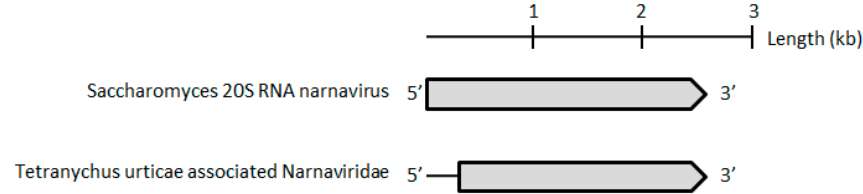
Figure 6. Maximum Narnaviridae likelihood phylogenetic tree based on part of the polymerase protein, including 129 species and Tetranychus urticae-associated narnavirus (in bold). The alignment of 121 amino acids in length was produced using MUSCLE 3.7 (16 iterations) and was ungapped by hand. Bootstrap values are indicated at each node. Scale bar corresponds to amino acid substitutions per site. Genomic organization of Tetranychus urticae-associated narnavirus is also indicated. Grey arrows: putative NS.